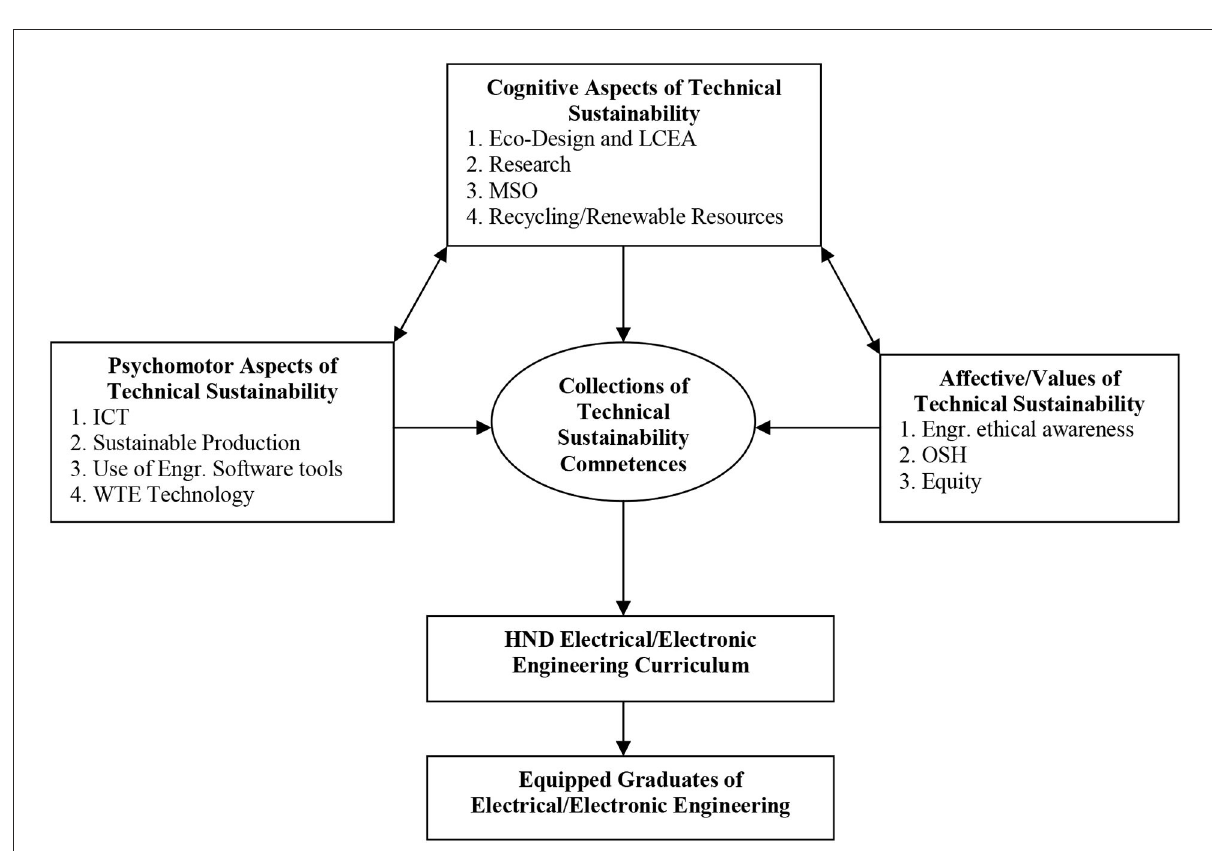
FIGURE3 Proposed model of technical sustainability for integration into HND electrical/electronic engineering curriculum in